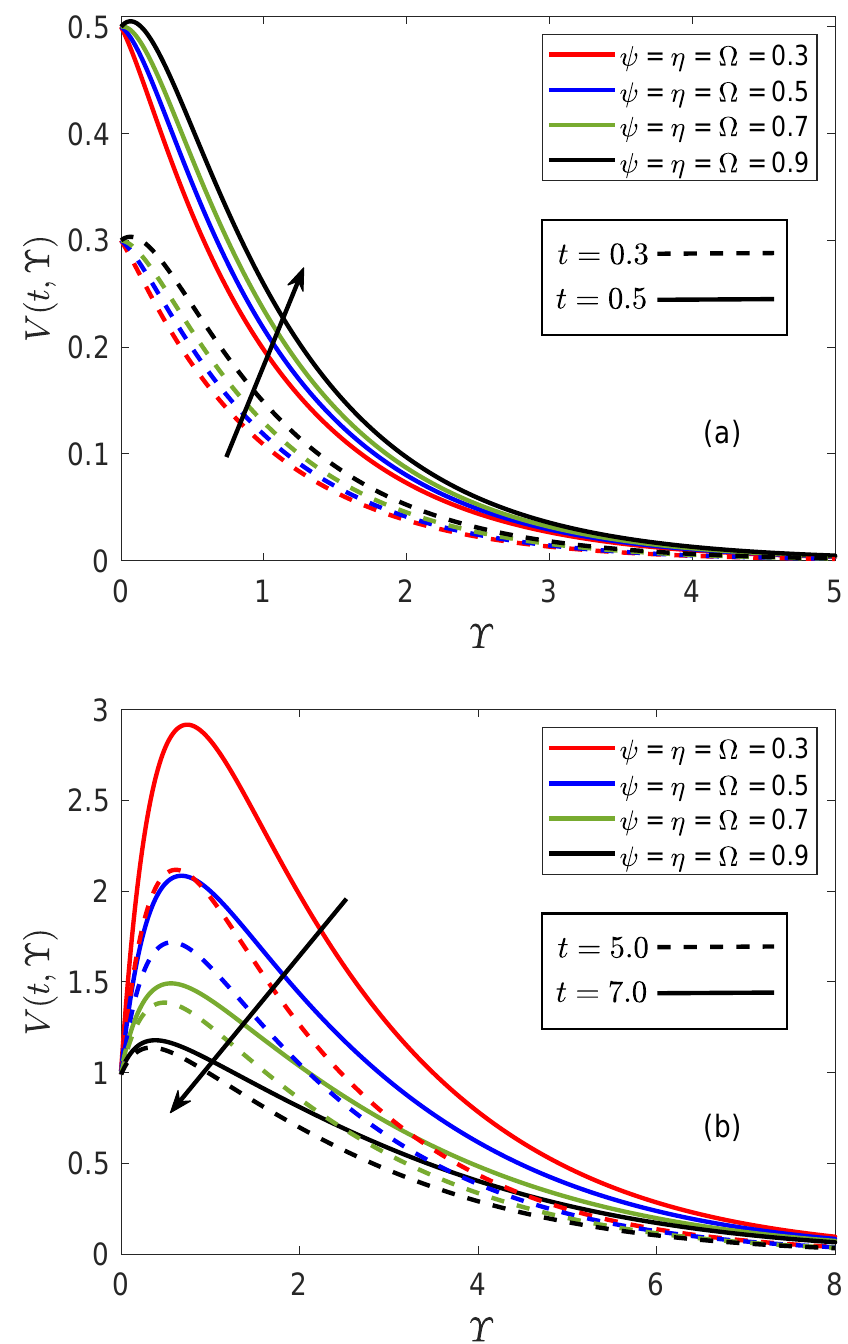
Figure 3. ( a ) Flow profile corresponding to variation of ψ , η , and Ω for smaller time inputs. ( b ) Flow profile corresponding to variation of ψ , η , and Ω for larger time